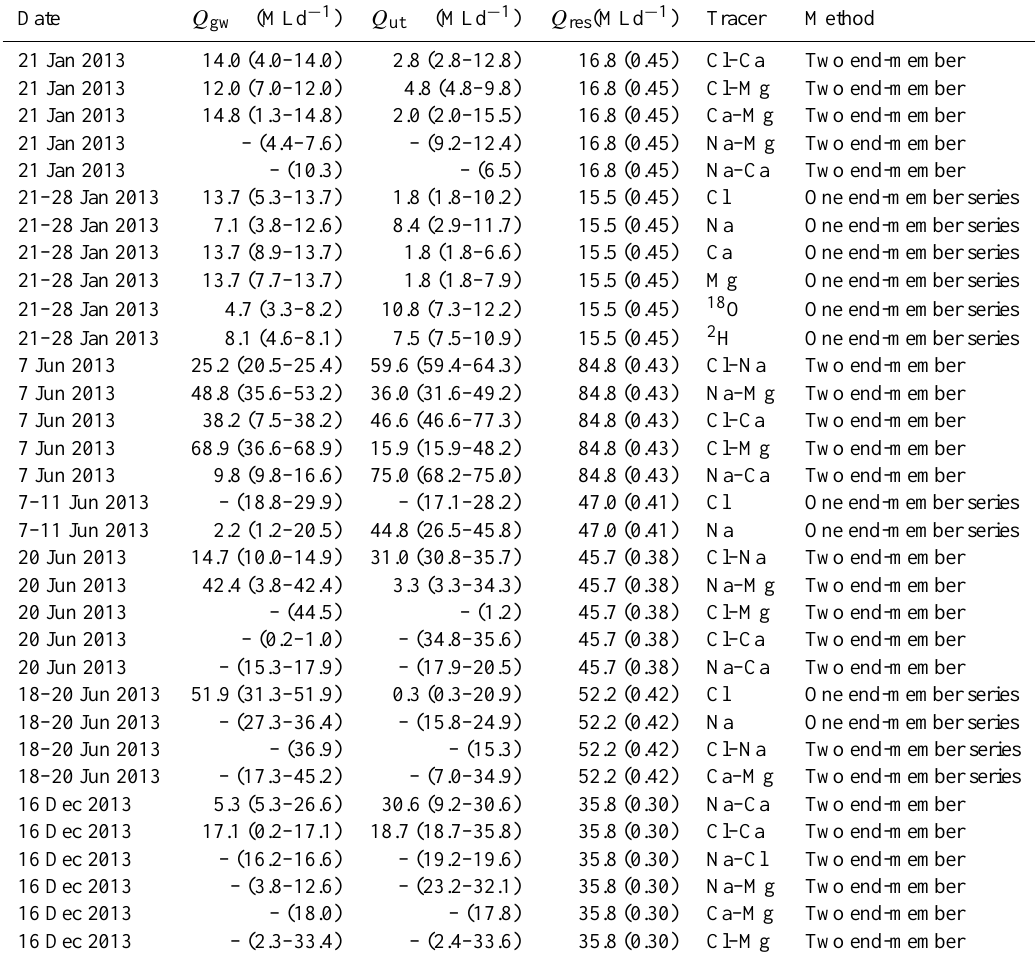
Table 1. Estimates of groundwater discharge ( Q gw ) and ungauged tributary discharge ( Q ut ) using mass balance analysis and mean measured compositions of groundwater and ungauged tributary flow. The values within the brackets are the range of valid discharges generated by varying the groundwater composition by 1 standard deviation for each ion used in the analysis. Q res is the residual discharge after accounting for the gauged discharges within the study catchment and the following value in brackets is the ratio of Q res to the total streamflow measured at Bunker Hill gauging